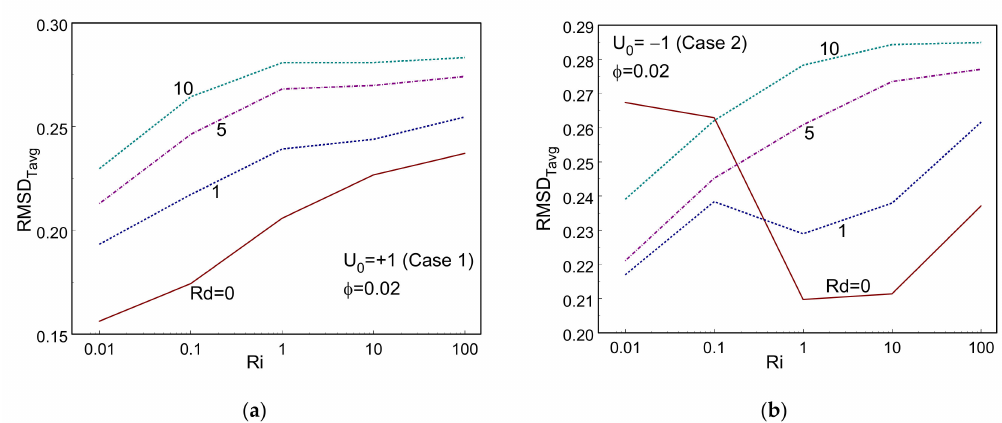
Figure 14. RMSD Tavg for di ff erent Ri and Rd values. ( a ) Case 1; ( b ) Case